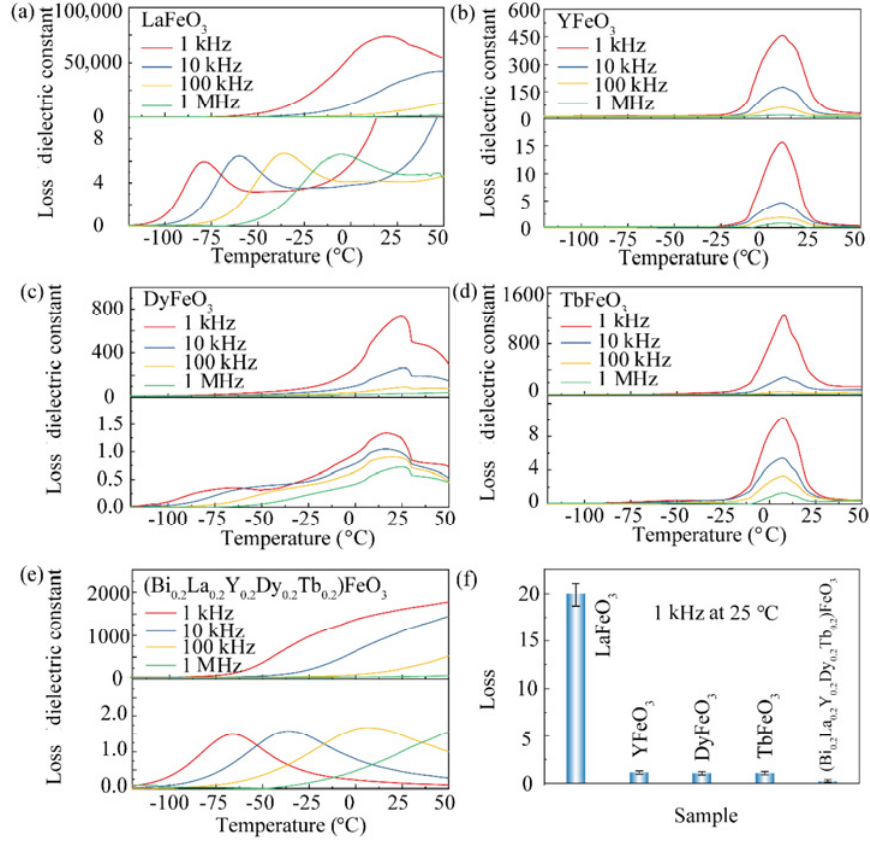
Fig. 8 Temperature-dependent dielectric constants and losses: (a) LaFeO 3 , (b) YFeO 3 , (c) DyFeO 3 , (d) TbFeO 3 , (e) BLYDTFO, and (f) losses of samples at 1 kHz at room